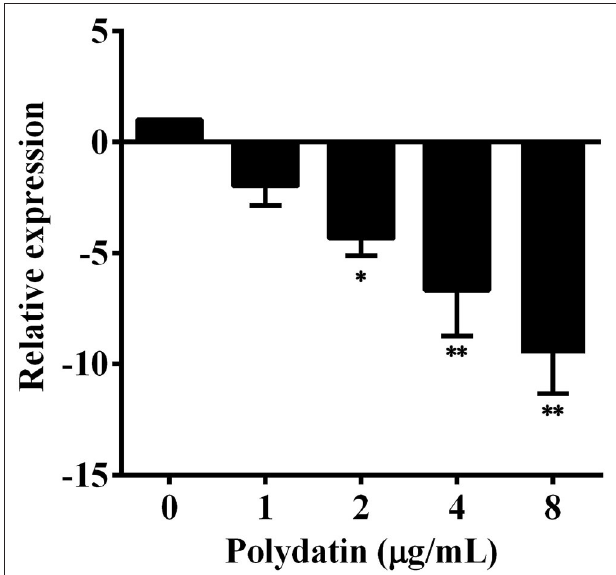
FIGURE 2 | Effects of polydatin on the expression levels of the aerA gene. Data are represented as the mean ± SD of three independent assays, * indicates p < 0.05, ** indicates p <